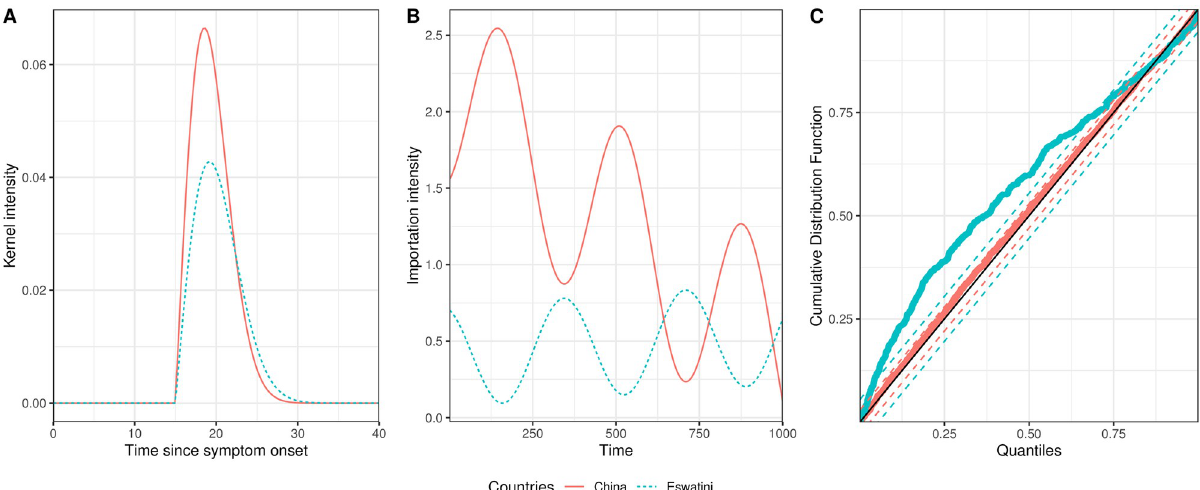
Fig 4. Fitted endogenous and exogenous terms for the China and Eswatini data. Fig 4A shows the fitted kernel intensity for a single infection, which corresponds Eq (5). Fig 4B shows how the exogenous terms vary through time. Fig 4C shows results from the Kolmogorov–Smirnov goodness of fit tests. The solid red lines and dots correspond to the China data and the dashed blue lines and dots correspond to the Eswatini data. The black solid line in Fig 4C is the line y = x and the red and blue dashed lines are the 95% confidence intervals for the China and Eswatini data set respectively.